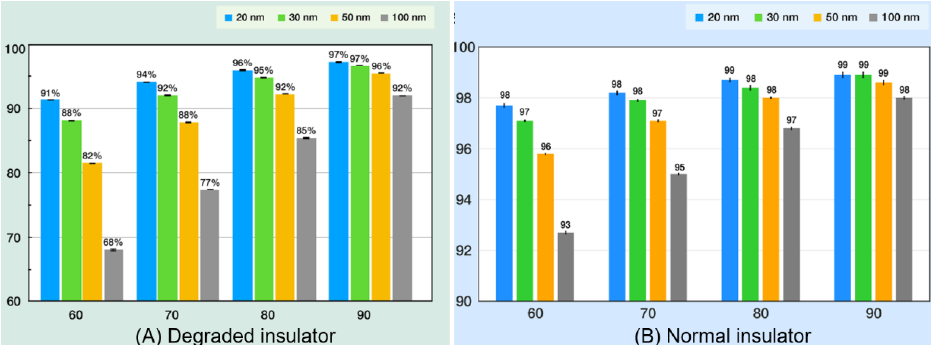
Fig. 2 Colour histogram of a single piece of degraded/standard